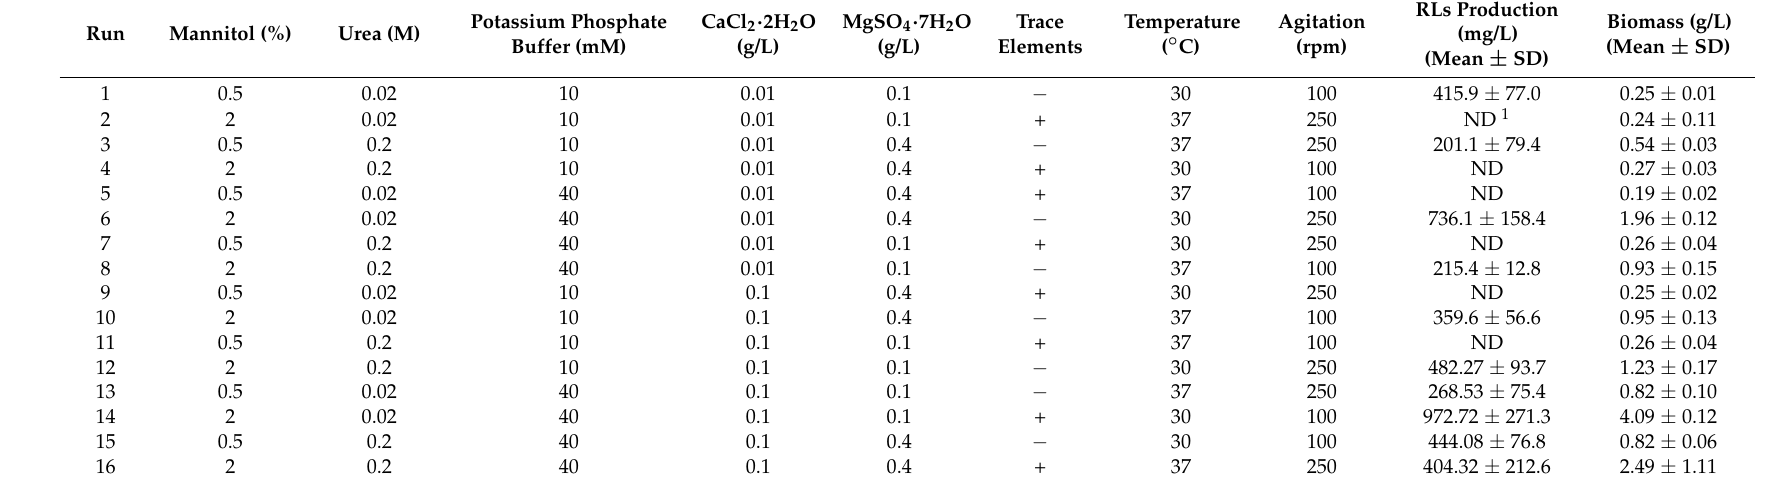
Table 3. Experimental design and results of the fractional factorial